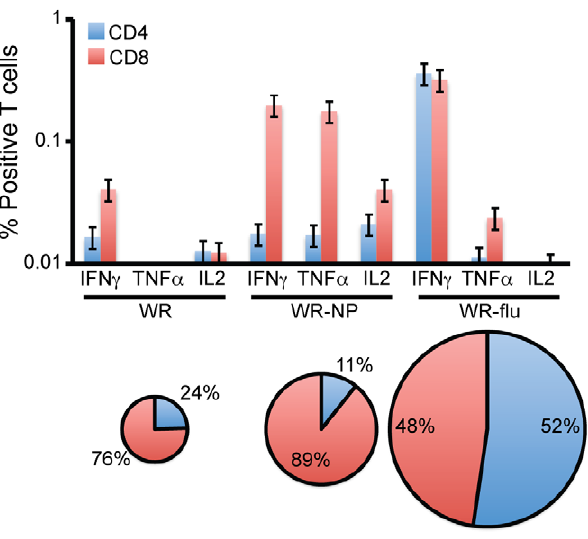
Figure 5. Phenotypic analysis of vaccine-induced CD4 + and CD8 + T cell responses. The same groups of splenocytes as described in Figure 4 were stimulated with the influenza virus NP-specific peptide and analyzed using polychromatic flow cytometry. The results represent the mean number of CD4 + and CD8 + T cells secreting IFN c , TNF a , or IL2 in each immunization group using three biological replicates 6 standard error. The background from unstimulated controls was subtracted in all cases. The pie charts represent the magnitude and percentage of CD4 + and CD8 + T cells secreting cytokines in each immunization